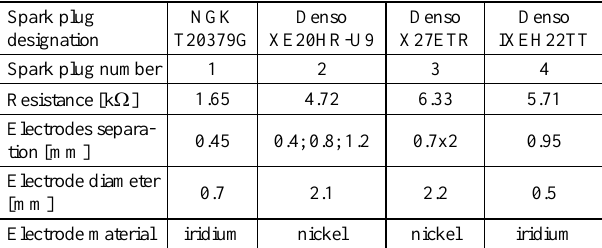
Table 2. Parameters of the spark plugs